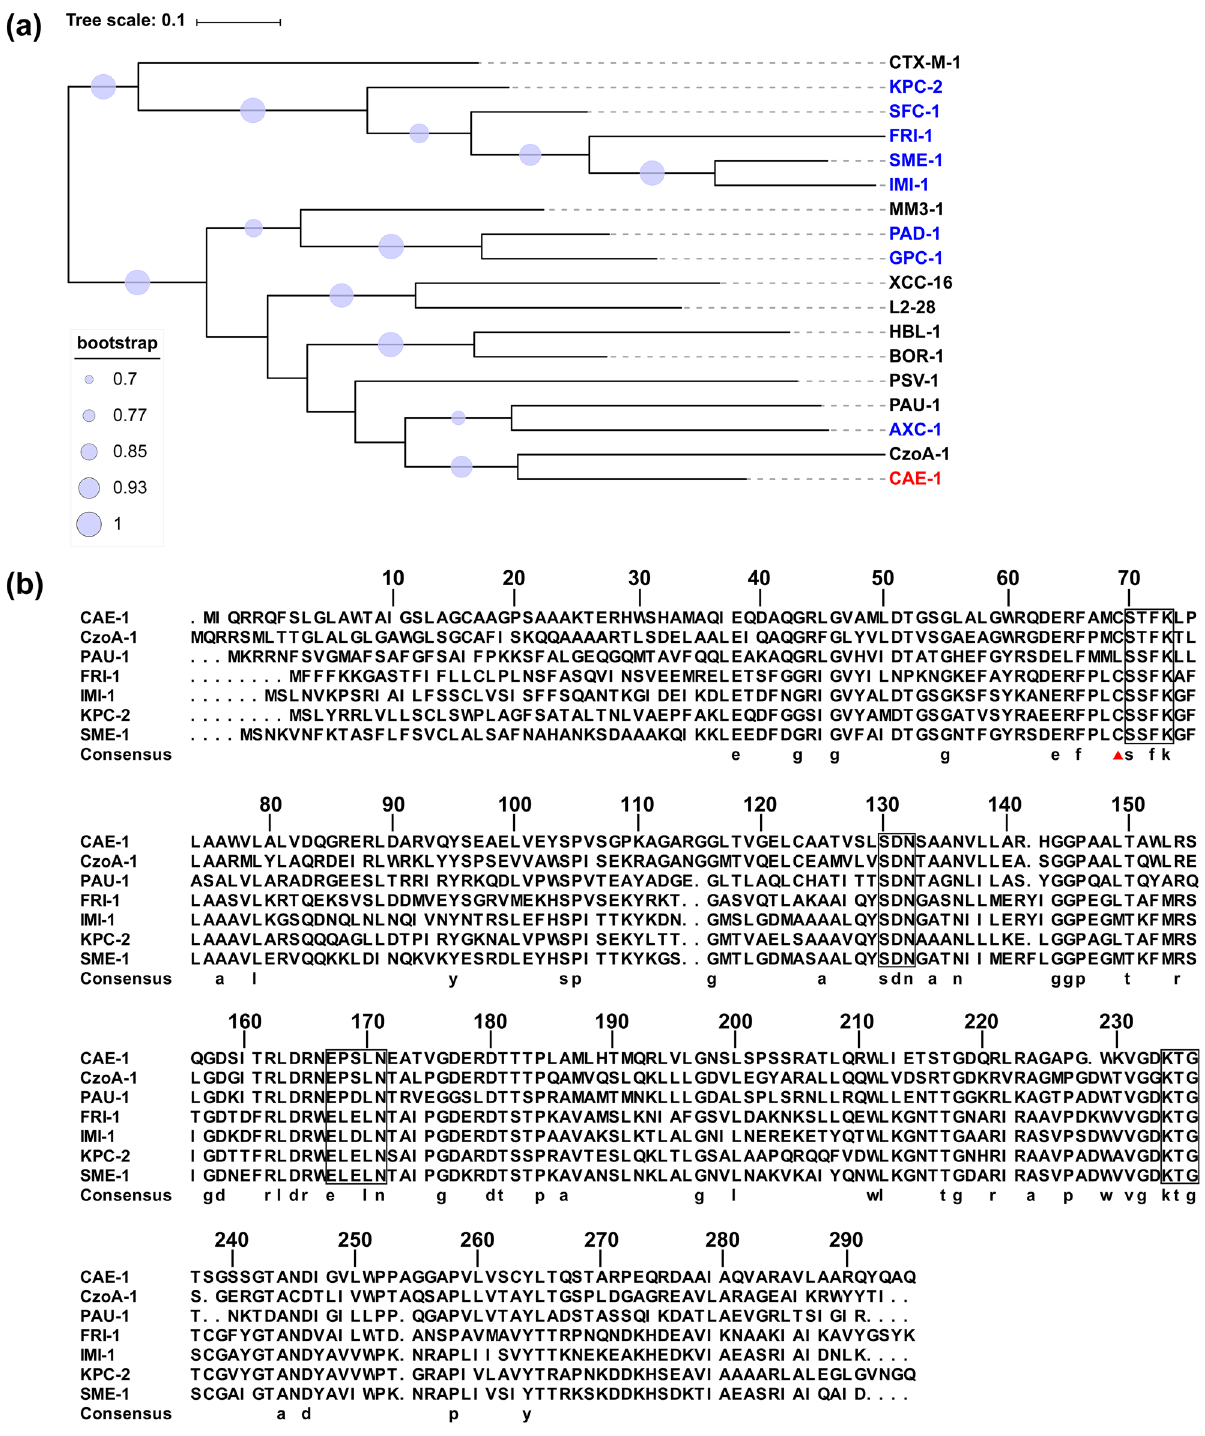
Figure 1. Comparison of CAE-1 with other known class A beta-lactamase. ( a ) An unrooted phylogenetic tree of CAE-1 and its close homologs and representative class A beta-lactamase. Proteins with carbapenemase activity are highlighted in blue and CAE-1 is in red. The tree scale indicates substitutions per site. The β-lactamases (GenBank accession numbers) are CTX-M-1(DQ915955), KPC-2 (LDDY01000008), SFC-1(AY354402), FRI-1(KT192551), SME-1 (Z28968), IMI-1 (U50278), MM3-1 (MK831000), PAD- 1(LNTU01000040), GPC-1 (MH211206), XCC-16 (QUZR01000001), L2-28 (CP011010), HBL-1 (CP012077), BOR-1 (BX640443), PSV-1 (KU926347), PAU-1 (KU881625), AXC-1 (MF767301), and CzoA-1 (ADVQ01000062). ( b ) Amino acid sequence alignment of CAE-1 with CzoA-1, PAU-1, FRI-1, IMI-1, KPC-2 and SME-1. The residue numbers are positioned above the sequences according to the standard numbering scheme for the class A beta-lactamases 39 . The four conserved motifs of class A β-lactamases are outlined in black and the red triangle indicates the conserved residue 69 C among class A